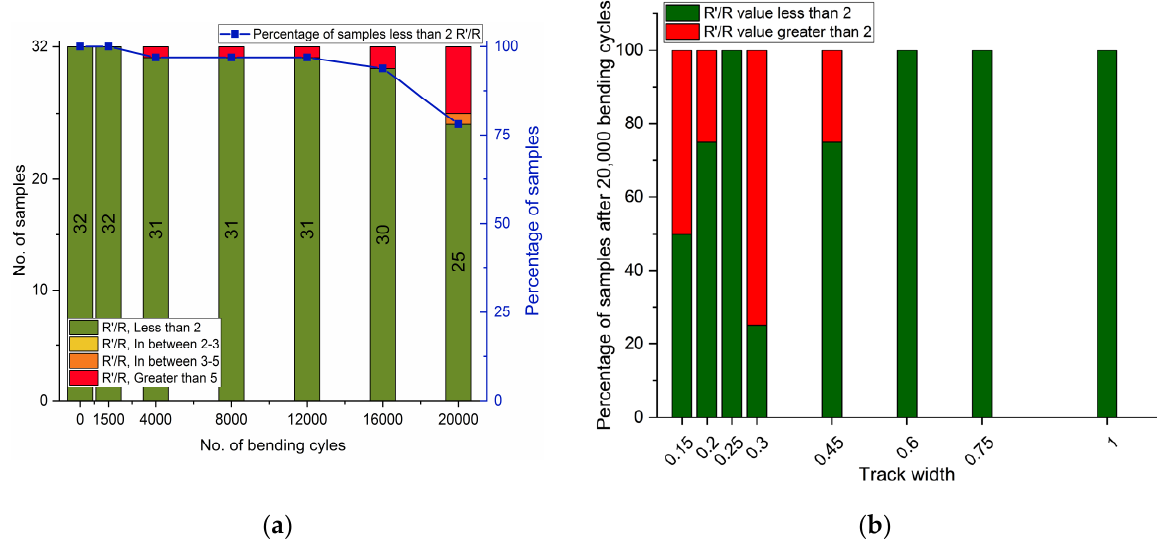
Figure 14. FPCB sample (with silicone protection) analyses after 20,000 bending cycles, a total of 32 samples were tested: ( a ) No. of samples with R’/R values increased above 2, 3, and 5 on the left y-axis and percentage of samples having R’/R value below 2 on the right y-axis; ( b ) ratio of samples having R’/R values below and above 2 after complete washing cycles based on track widths.